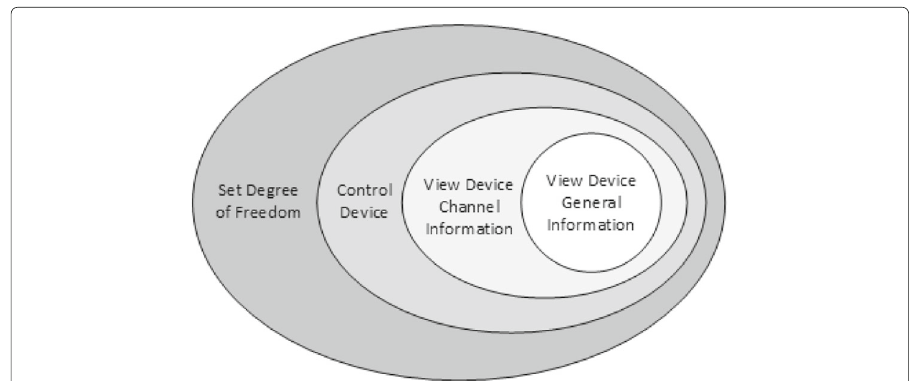
Fig. 3 The permission hierarchy of the four operations for